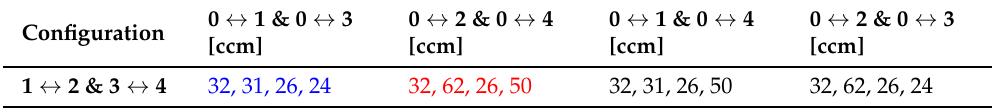
Table 1. Necessary displacements in crane application for different interconnection schemes with VDN-PP topology. The blue colored case marks the scheme with the lowest displacement sum and the red colored case marks the scheme with the highest displacement